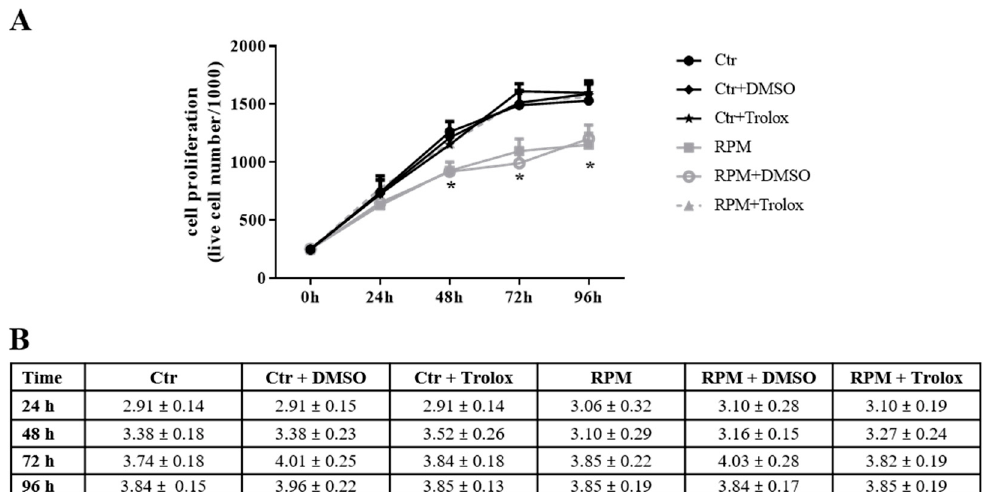
Figure 6. Cell proliferation restoring by Trolox. ( A ) Proliferation of live cells cultured, up to 96 h, at 1 g (Ctr) and s-microgravity (RPM) in absence or presence ( + Trolox) of 100 µ M Trolox or its vehicle solution (1 µ L in 1 mL of medium) ( + DMSO). ( B ) Thypan Blue-stained cells, considered dead cells, in the same cell populations tested in A. Data are expressed as cell percentage and are presented as the means ± SEM from three independent experiments. * p < 0.05 vs . respective Controls . Complete data sets and statistical analyses are reported in Supplementary Tables (Table S11).